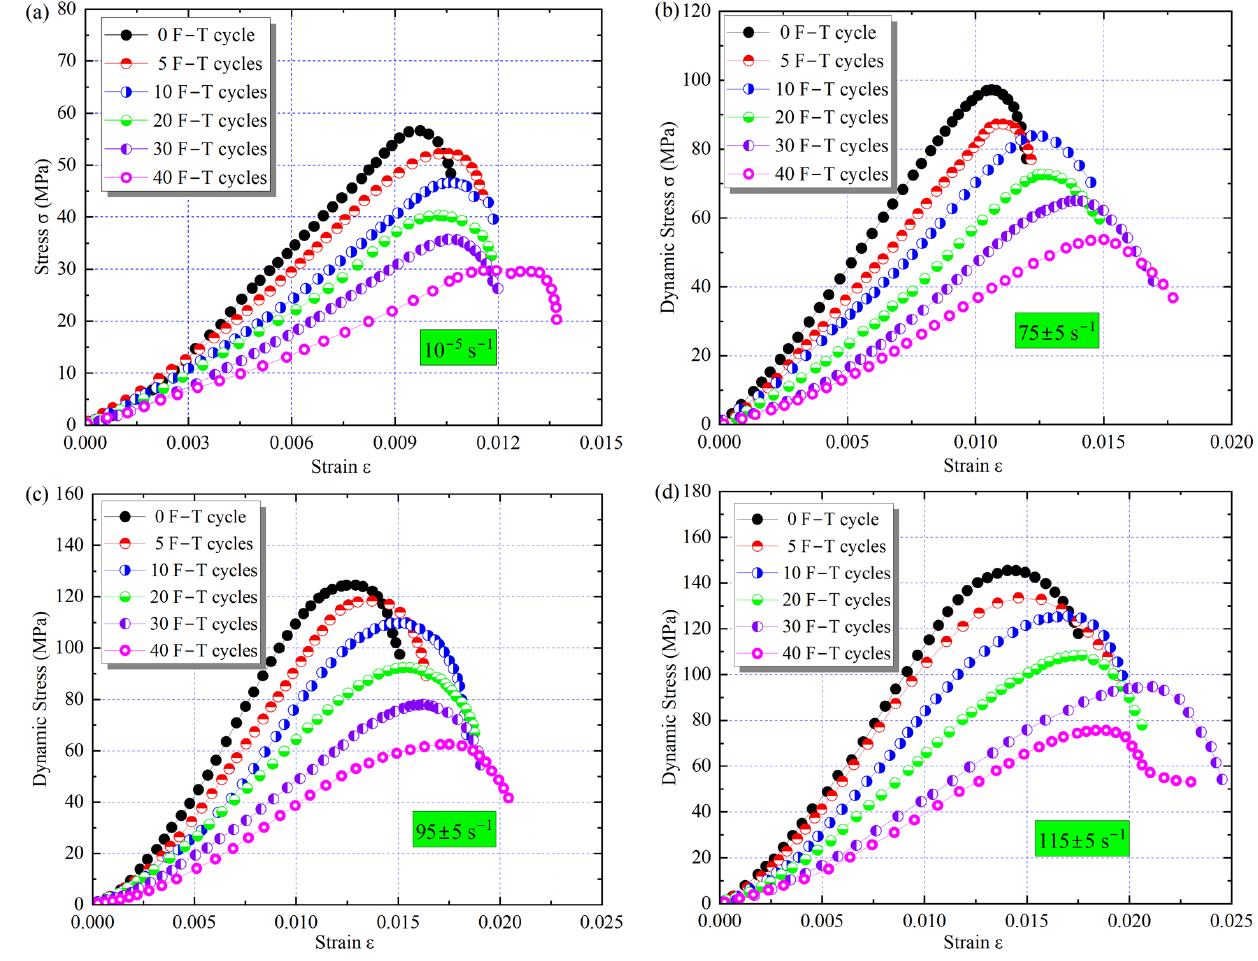
Figure 13. Stress–strain behavior under F–T action: ( a ) Static; ( b ) 75 ± 5 s − 1 ; ( c ) 95 ± 5 s − 1 ; ( d )115 ± 5 s − 1. ( d )115 ± 5 s − 1 .